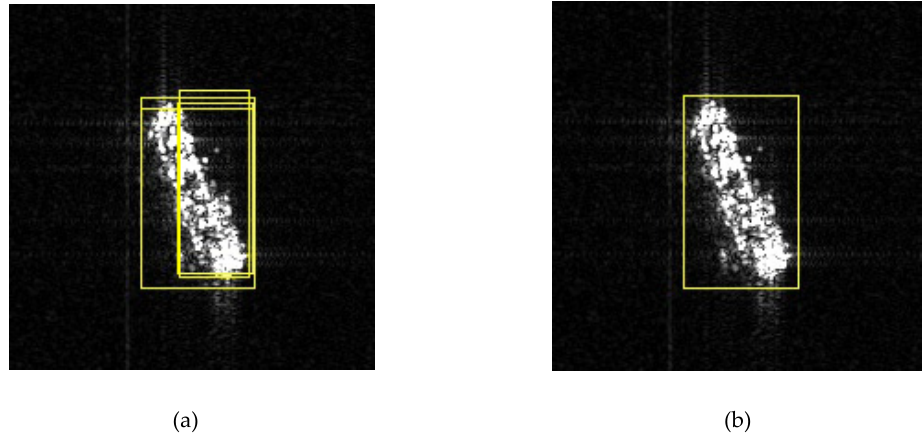
Figure 5. Procedure for consolidating the predicted boxes. ( a ) predicted boxes before consolidation; and ( b ) predicted box after consolidation. 332